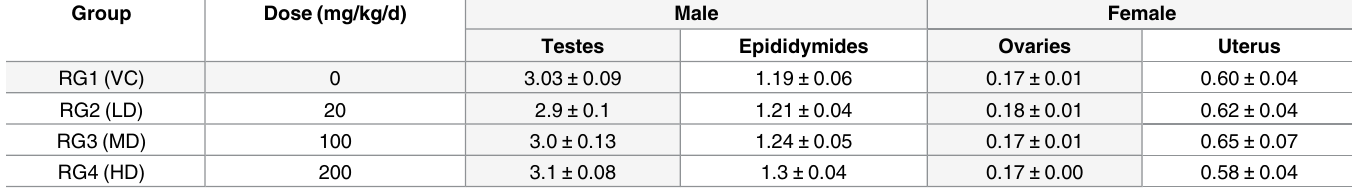
Table 8. Absolute organ weights (in g) of animals upon 3’-HPT administration in reproductive/ developmental toxicity study of 3’-HPT in Wistar rats.